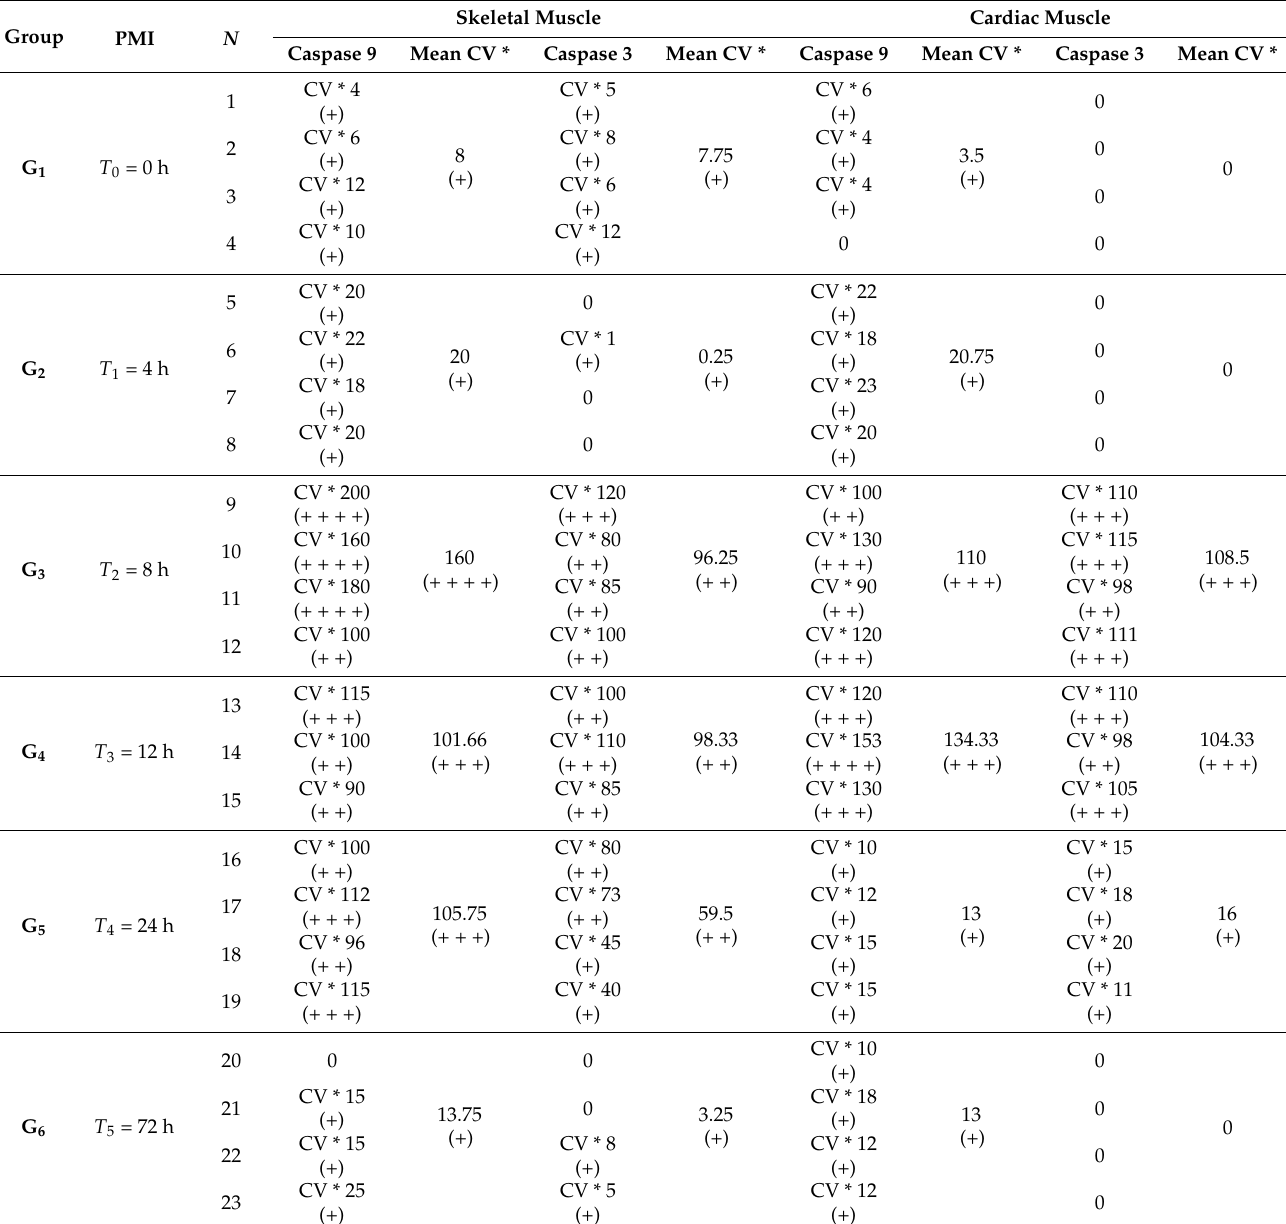
Table 1. Immunohistochemical reactivity to Caspase 9 and Caspase 3 on skeletal and cardiac muscle samples at each time point after